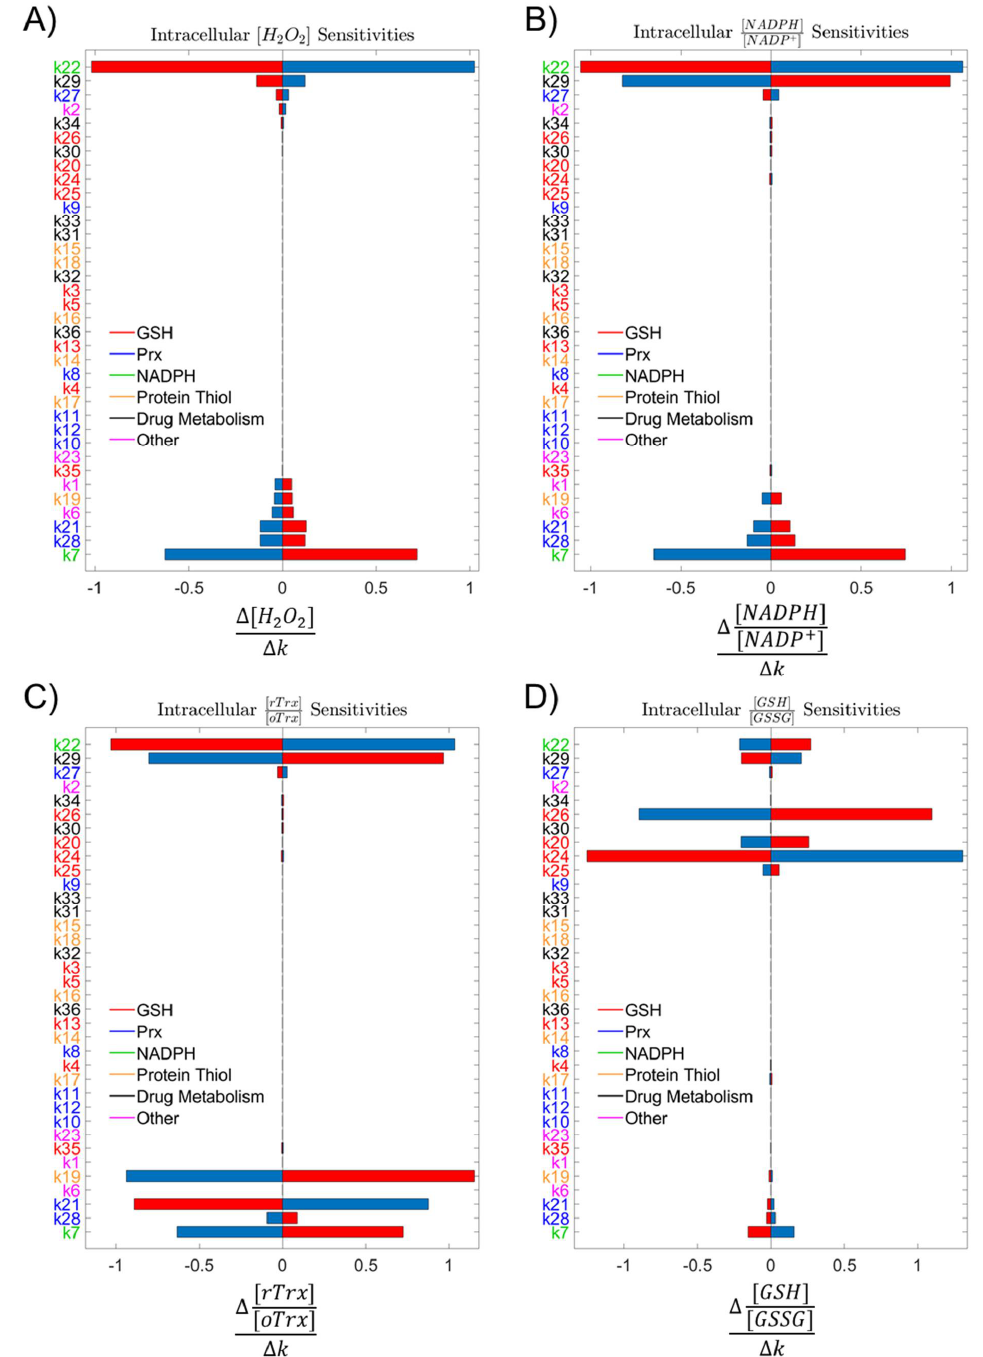
Figure 3. Sensitivity analyses. ( A ) Analysis of system sensitivity to single-parameter 10% perturbations colored by the antioxidant subsystem showed low sensitivity of ( A ) intracellular H 2 O 2 , ( B ) NADPH:NADP + , ( C ) Trx-SH:Trx-SS, and ( D ) GSH:GSSG at 2 h to any single parameter. Blue bars represent an increase in the parameter by 10%, and red bars represent a decrease in the parameter by